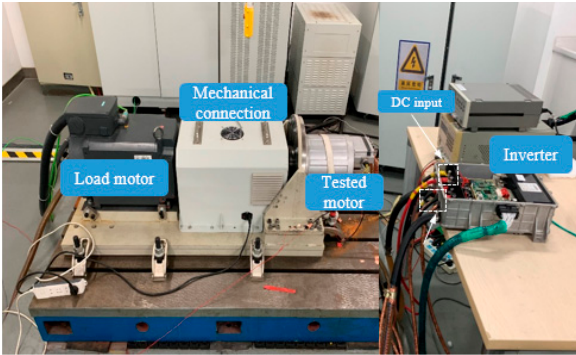
Figure 8. Photograph of the testing platform.